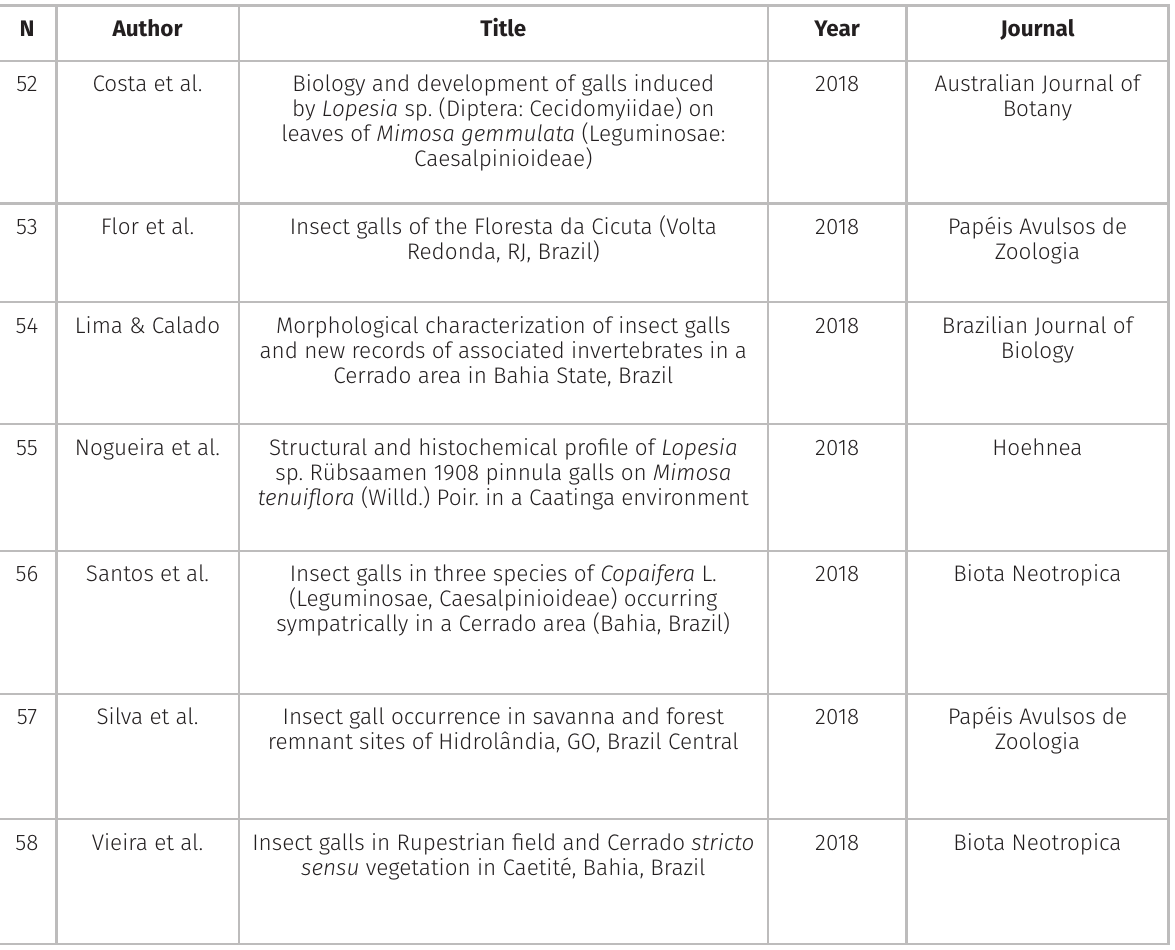
Table I. (continuation)